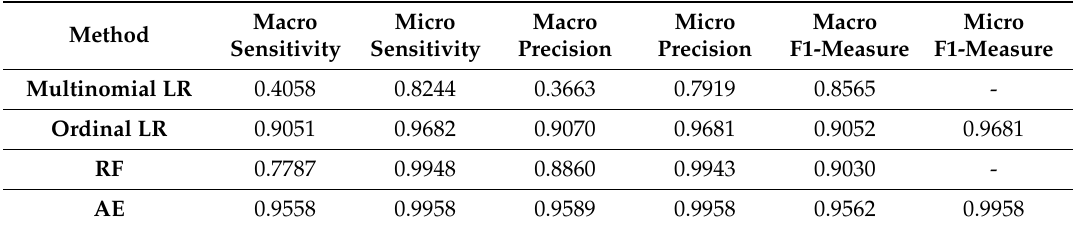
Table 5. Classification performance table (macro and micro